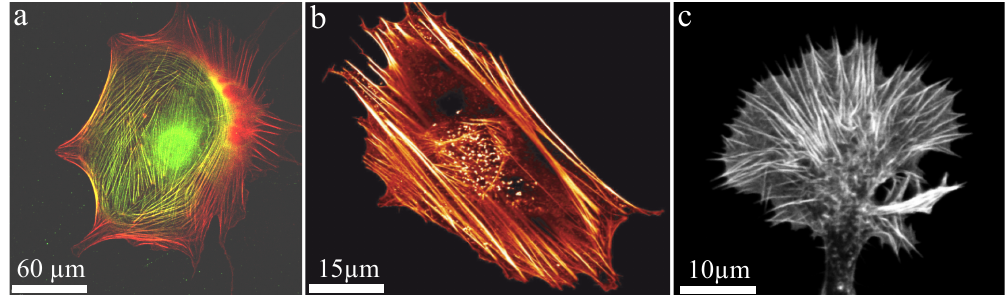
Figure 8. Actin bundles build up stress fibers within the cytoskeleton giving a cell structural stability. ( a , b ) Stress fibers entirely span throughout a stationary Balb3T3 fibroblast (( a ) myosin labeled green and actin red ; ( b ) actin red ); ( c ) actin bundles stabilize a NG108 neuronal growth cone and according filopodia. Images were taken by Thomas Fuhs and Daniel Koch and the figure is adapted from Huber et al. 2013